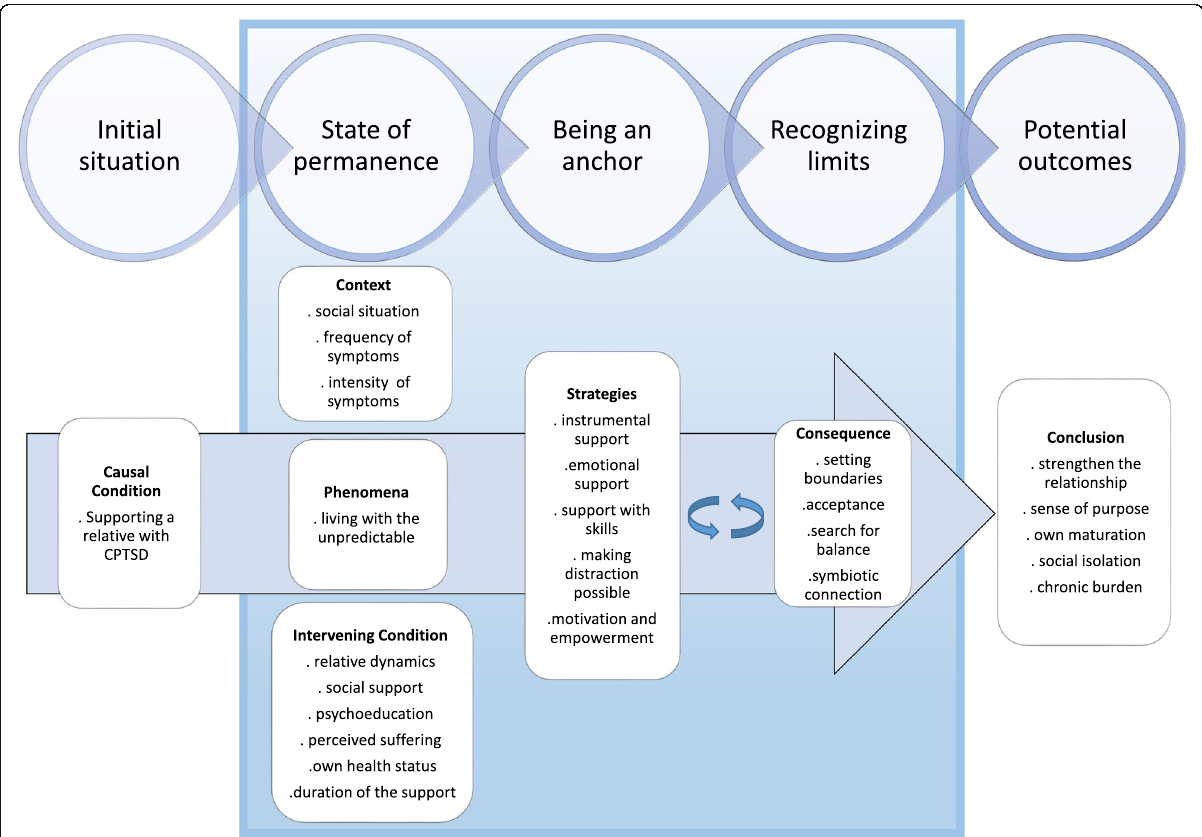
Fig. 1 Process model for symptom management of relatives of patients with